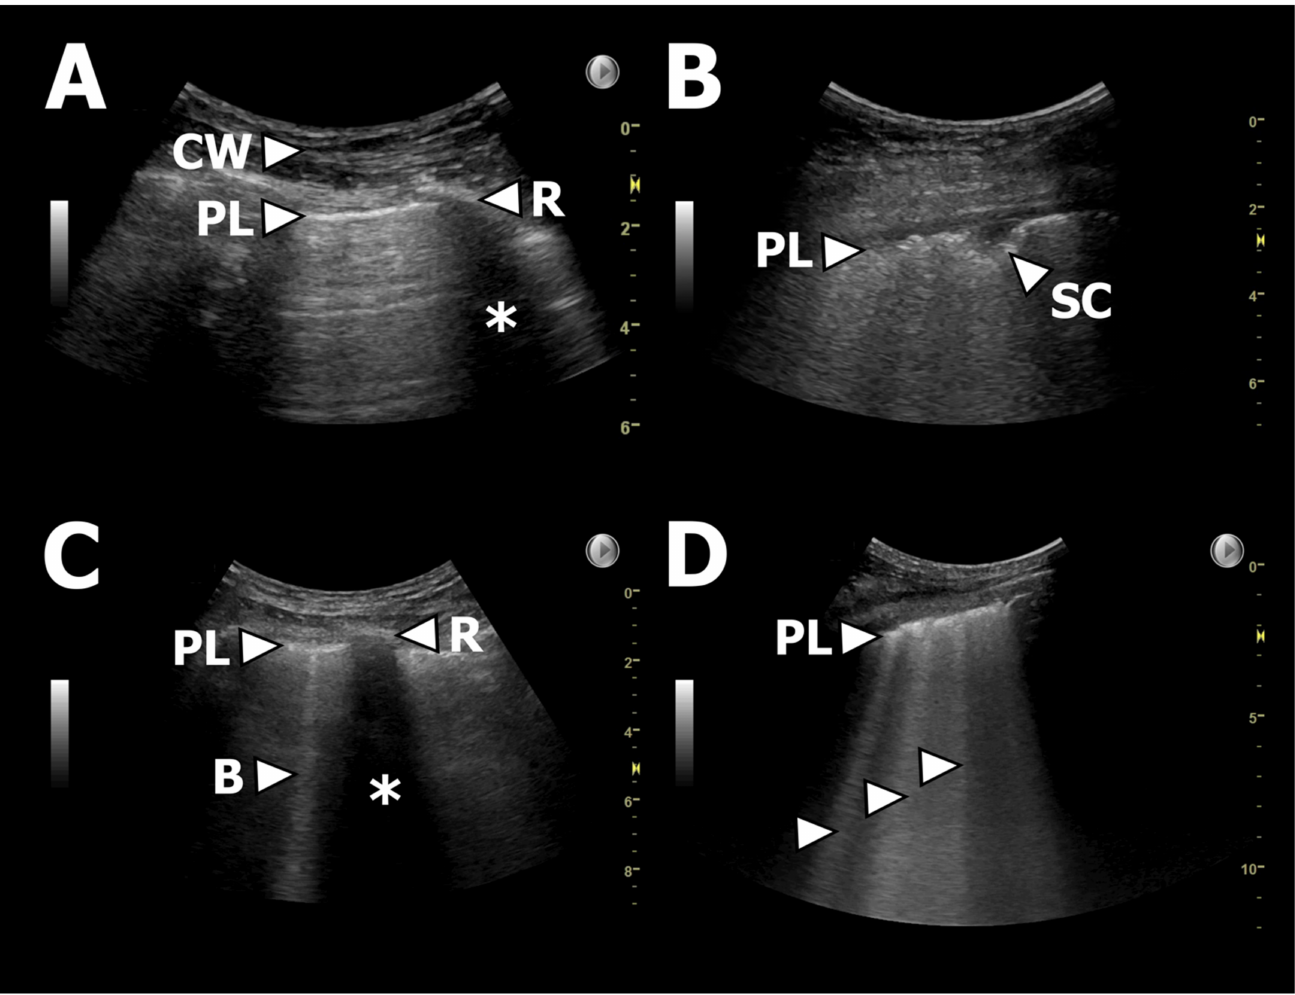
Figure 2. Examples of LUS findings. ( A ): Normal LUS. PL = pleural line, CW = chest wall, R = rib, * = rib shadowing. ( B ): Thickened/fragmented pleura and a small subpleural consolidation. PL = pleural line, SC = subpleural consolidation. ( C ): Single B-line. PL = pleural line, R = rib, * = rib shadowing, B = B-line. ( D ): Multiple B-lines as part of, e.g., IS. PL = pleural line, arrows =